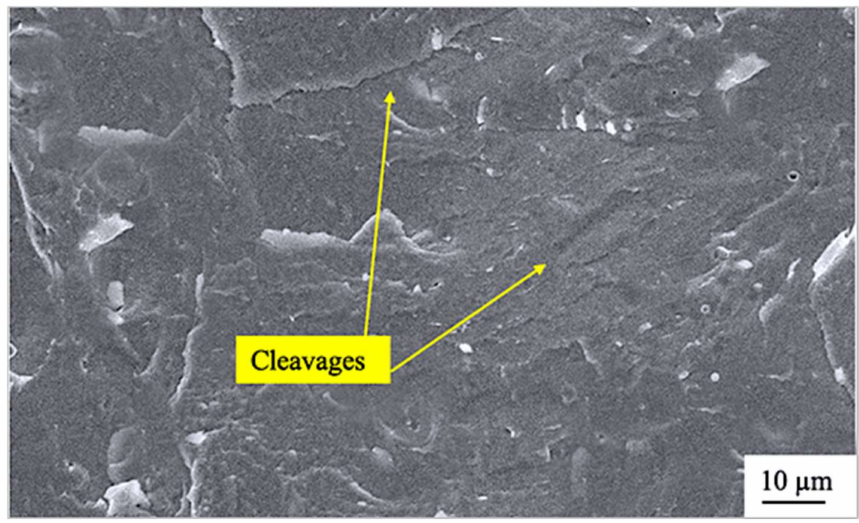
Figure 10. Cleavage